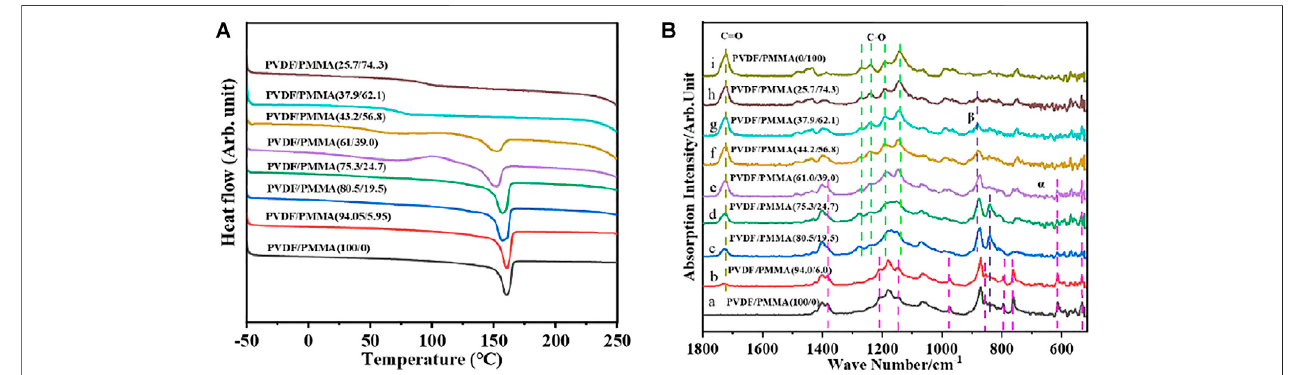
FIGURE 3 | (A) DSC curves and (B) FTIR spectra of PVDF/PMMA